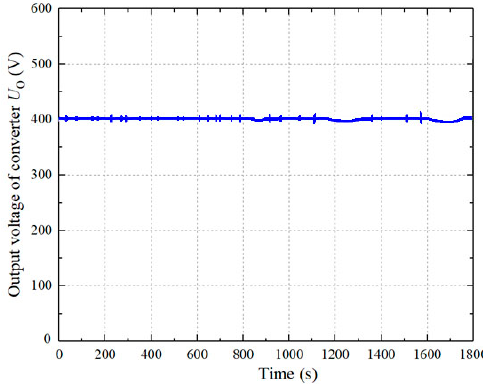
Figure 12. The output voltage of a converter under the WLTP.